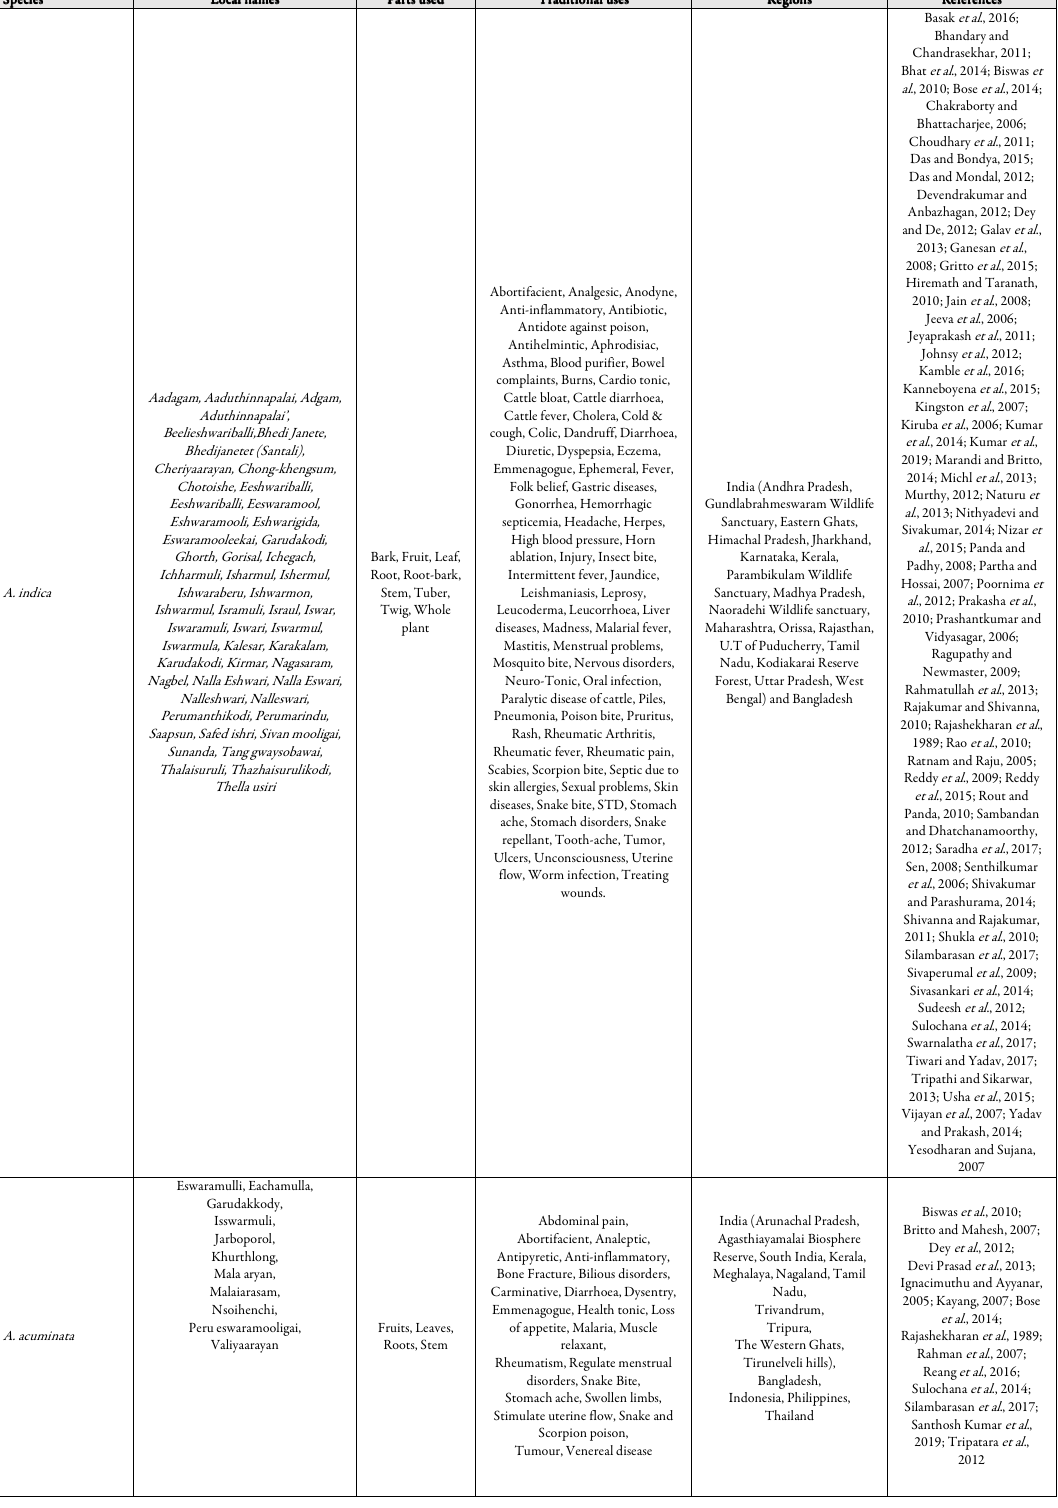
Table 1. Summary of traditional uses of the studied Aristolochia species outside Assam